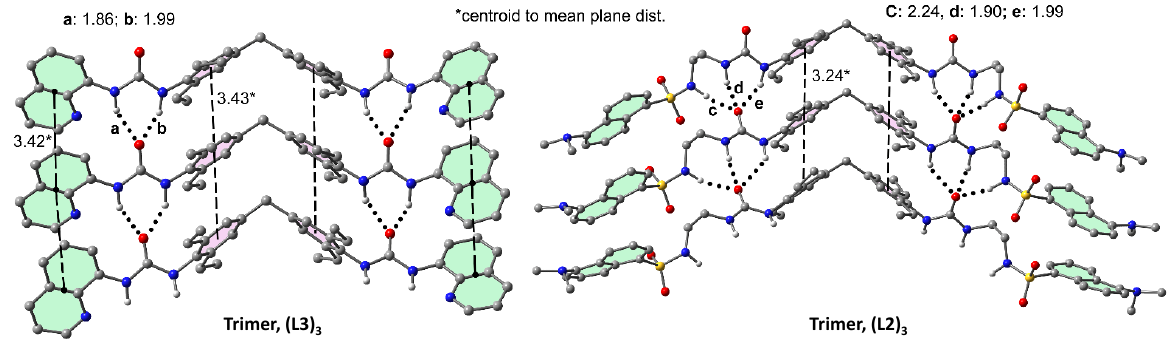
Figure 6. Optimised geometry (PB86-D3/def2-TZVP in DMSO) of the trimer of L3 ( left ) and L2 ( right ). Distances in Å for H-bonds labelled a, b, c, d and e, H atoms were omitted for clarity apart from those belonging to the